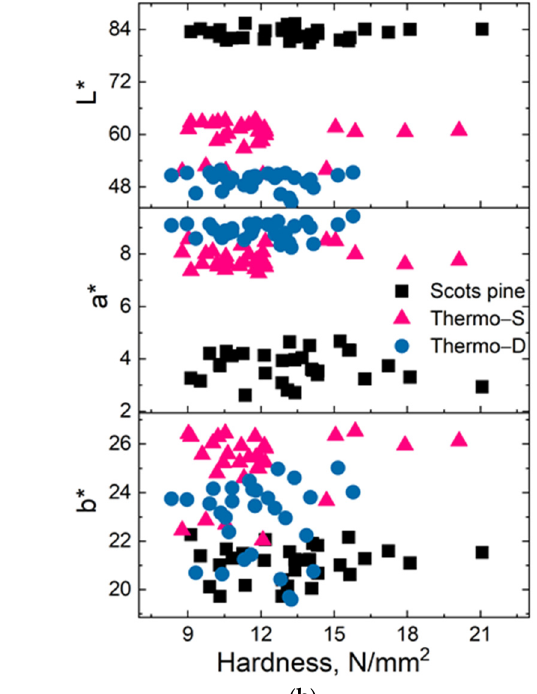
20 of 25 Figure 11. Brinell hardness measured after release of the force plotted as a function of PC1 and PC2